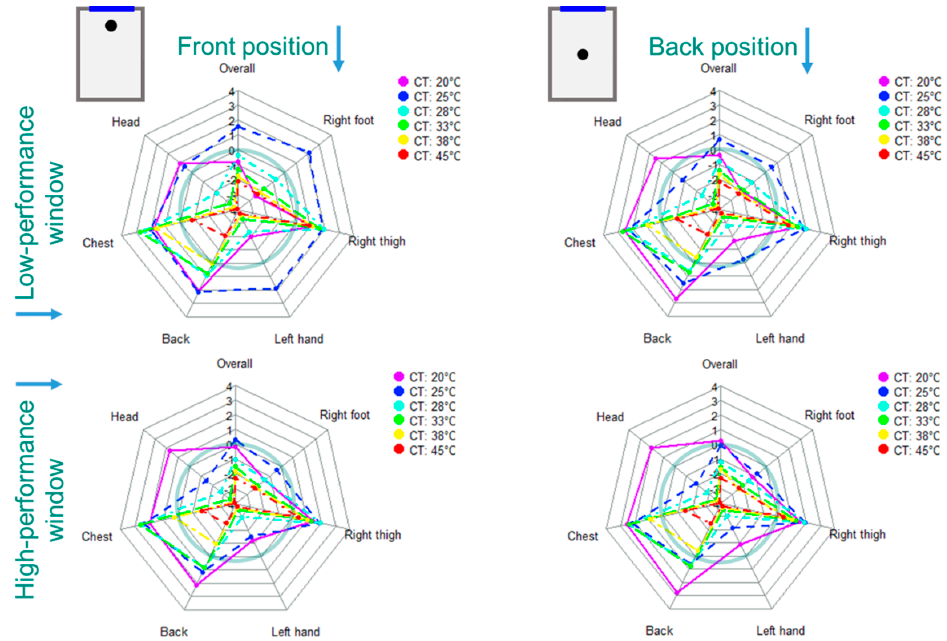
Figure 17. Overall and local thermal comfort at selected body limbs in the middle room influenced by ceiling temperatures, quality of facades, and the position of the manikin. Nine-point thermal comfort scale: “ − 4 = very uncomfortable”, “ − 2 = uncomfortable”, “0 − = just uncomfortable”, “0 + = just comfortable”, “+2 = comfortable”, and “+4 = very comfortable”.